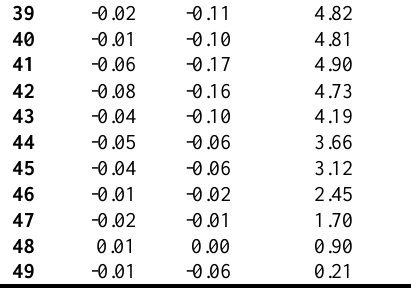
Table 4. Distance between the GCPs, GCSs and point cloud without any constraints along Z direction, using the photogrammetric point cloud as ground